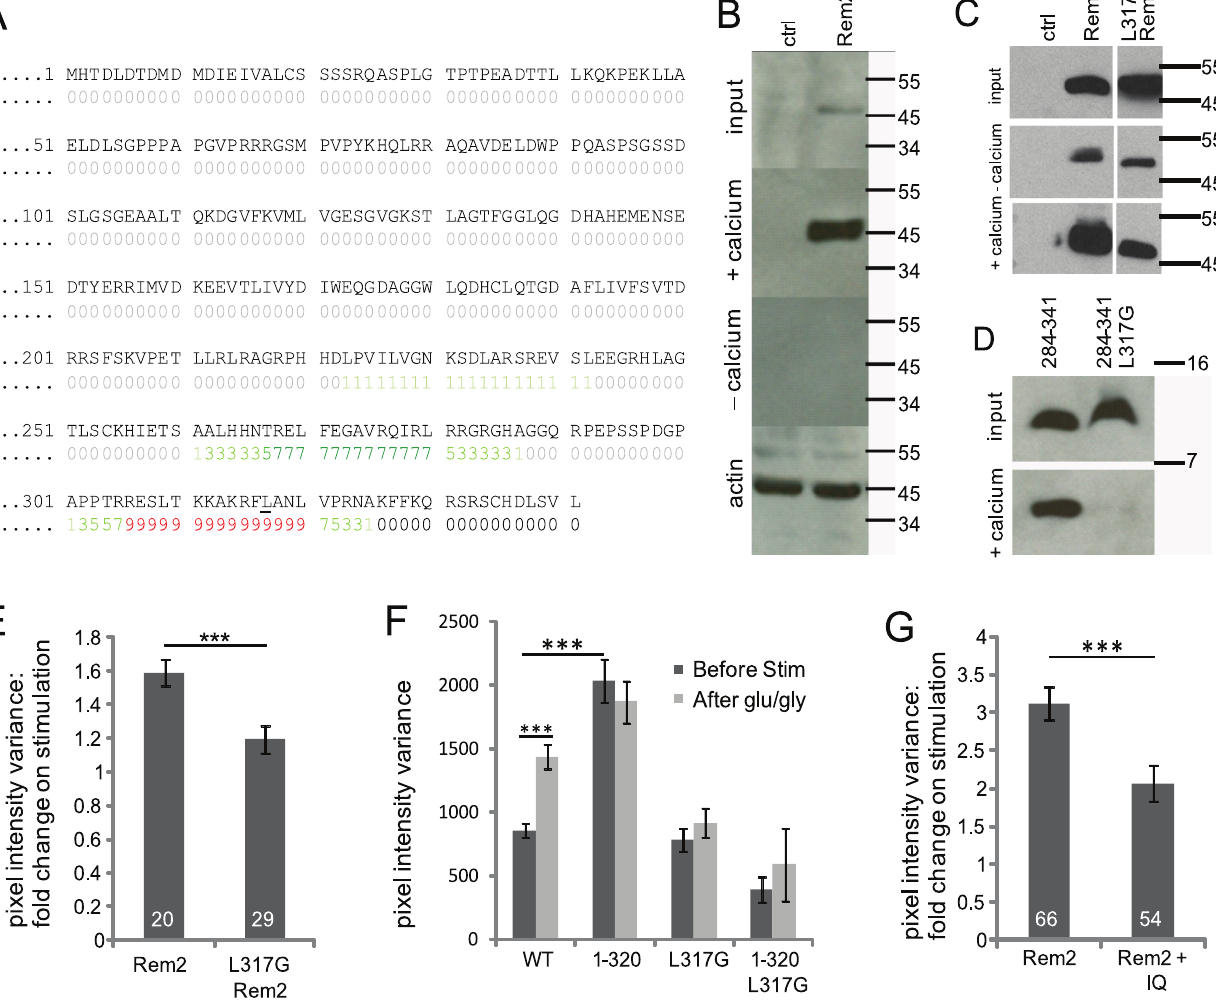
Figure 4. Calmodulin binding is necessary for Rem2 redistribution. ( A ) Predicted calmodulin binding sites in Rem2. An online predictor of calmodulin binding sites (http://calcium.uhnres.utoronto.ca/) suggests that Rem2 has two predominant sites, a higher affinity one close to the C- terminus and a lower affinity one further upstream. The colored numbers under the residues indicate how strongly a stretch of residues is predicted to bind CaM: grey 0 indicates no binding predicted, while red 9 indicates a likely CaM binding site. ( B ) Rem2 interacts with CaM in the presence of calcium. Untransfected HEK cells (ctrl) and HEK cells expressing full-length HA-tagged Rem2 (Rem2) were lysed, the lysates ( input ) cleared and passed over calmodulin-conjugated agarose beads in the presence of 3 mM calcium ( + calcium ) or 2 mM EGTA/2 mM EDTA ( –calcium ). Beta-actin was used as a loading control ( actin ). The eluate was subjected to Western blot analysis using HA antibody (top three panels) or actin antibody (bottom panel). ( C ) The point mutation L317G does not affect the association of full-length Rem2 with CaM. HEK cell lysates containing wild-type HA- Rem2 or the point mutation L317G were used for a pulldown assay with CaM-sepharose beads. Precleared lysates ( input ) and the eluates pulled down in buffer containing 2 mM EDTA/2 mM EGTA in place of calcium ( 2 calcium ) or 3 mM CaCl 2 ( + calcium ) were separated by SDS-PAGE and transferred to nitrocellulose membranes, then probed with anti-HA antibody. Control cells are untransfected. Note less signal in the presence of EDTA/EGTA. ( D ) The same mutation abolishes interaction between CaM and the Rem2 C-terminal extension. Upper panel shows cleared lysates (input) from HEK cells expressing Rem2 (284–341) and Rem2 (284–341) L317G. Lower panel ( + calcium) shows Rem2 protein pulled down with CaM- sepharose in the presence of 2 mM calcium. ( E ) Rem2-calmodulin interaction is necessary for Rem2 redistribution. Neurons expressing either wild- type or Rem2 (L317G) protein were imaged before and after stimulation with 100 m M glutamate/10 m M glycine. Ratio after/before stimulation of WT Rem2, 1.59 6 0.07, N=20; Rem2 (L317G), 1.19 6 0.08, N=29; t-test p=0.001. ( F ) Pixel intensity variances are shown before (dark bars) and after (light bars) stimulation. The variance of full length Rem2 changes upon stimulation (before, 858 6 53; after, 1429 96, N=29; paired t-test p , 0.001). The truncated mutant Rem2 (1–320) shows high variance before and after stimulation (before, 2035 6 165; after, 1871 6 161, N=39), indicating constitutive puncta, while the Rem2 L317G and the 1–320 truncation carrying the L317G mutation show low variances (Rem2 L317G before, 784 6 87; after, 918 6 117, N=29; Rem2 (1–320) L317G before, 392 6 101; after, 590 6 283, N=10), indicating no constitutive puncta and little redistribution on stimulation. One-way ANOVA + Bonferroni post-hoc test comparing variances before stimulation shows significant differences between full length Rem2 and Rem2 (1–320) (p , 0.0001), and no difference between full length and Rem2 L317G or Rem2 (1–320) L317G (p=1 and 0.42, respectively). Rem2 (1–320) L317G data come from 10 cells from a single transfection. ( G ) Coexpression of a CaM-binding IQ motif reduces Rem2 redistribution. Neurons cotransfected with YFP-Rem2 and CFP-IQ (TVGKFYATFLIQEYFRKFKKRKEQ) were imaged before and after stimulation with 25 m M glutamate/ 2.5 m M glycine. Ratio after/before stimulation of Rem2 alone, 3.12 6 0.22, N=66; Rem2 + IQ motif, 2.07 6 0.23, N=54; t-test p=0.0013.